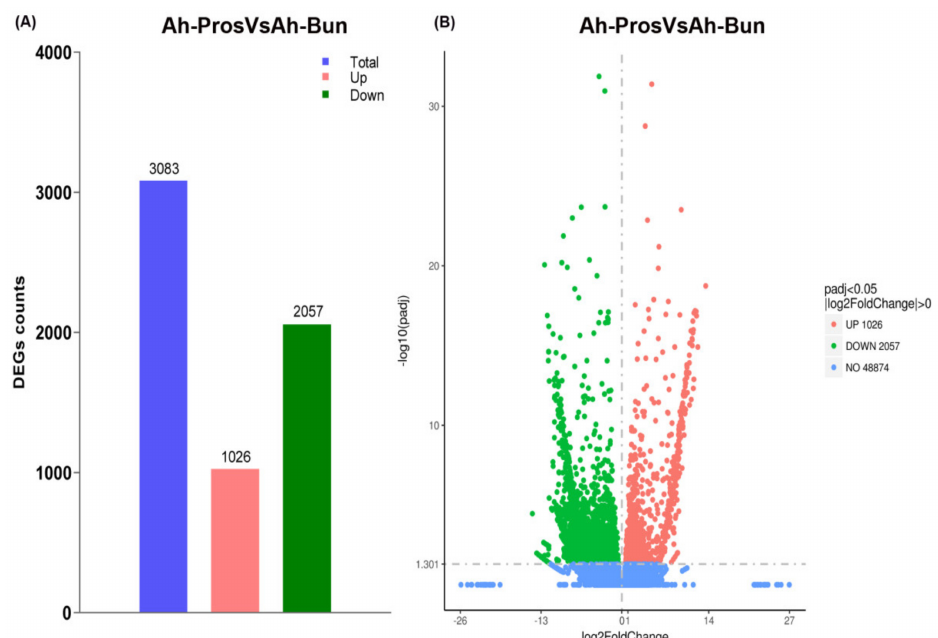
Figure 3. Differentially expressed genes between prostrate and bunch-type peanut ( A ) the statistics of DEG count in prostrate and bunch-type peanut. The blue color represents the total number of DEGs, pink and green color showed up-regulated and down-regulated differential genes, respectively ( B ) The abscissa in the figure represents the fold change of gene expression (log2FoldChange) between prostrate and bunch peanut. The ordinate represents the significance level of the difference in gene expression between two groups ( − log10padj or − log10pvalue). The up-regulated genes are represented by red dots, and the down-regulated genes are represented by green dots.